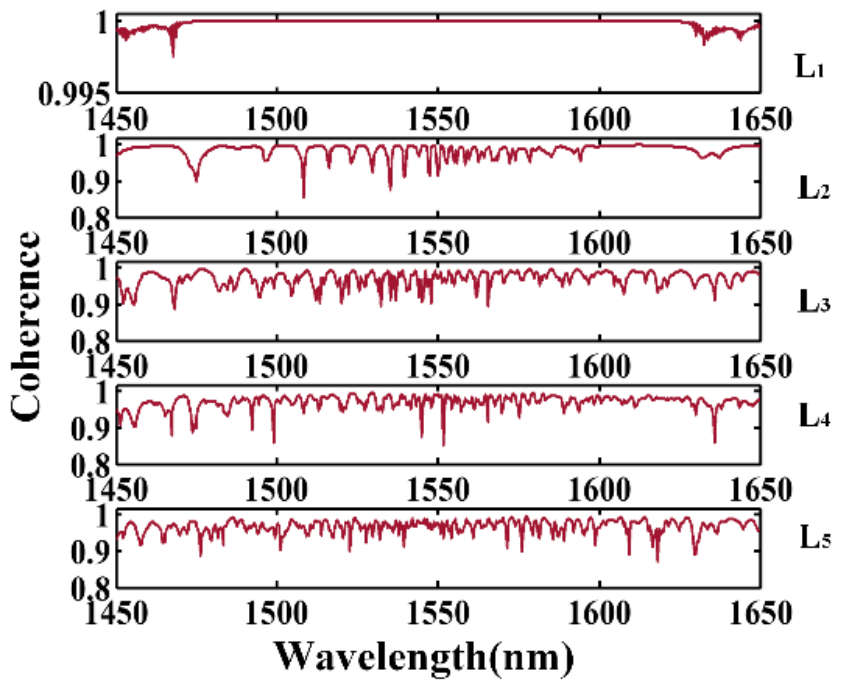
Figure 7. The coherence of the generated OFC from 1450 nm to 1650 nm after different ND and AD zones of optimized CSAD-TMF.